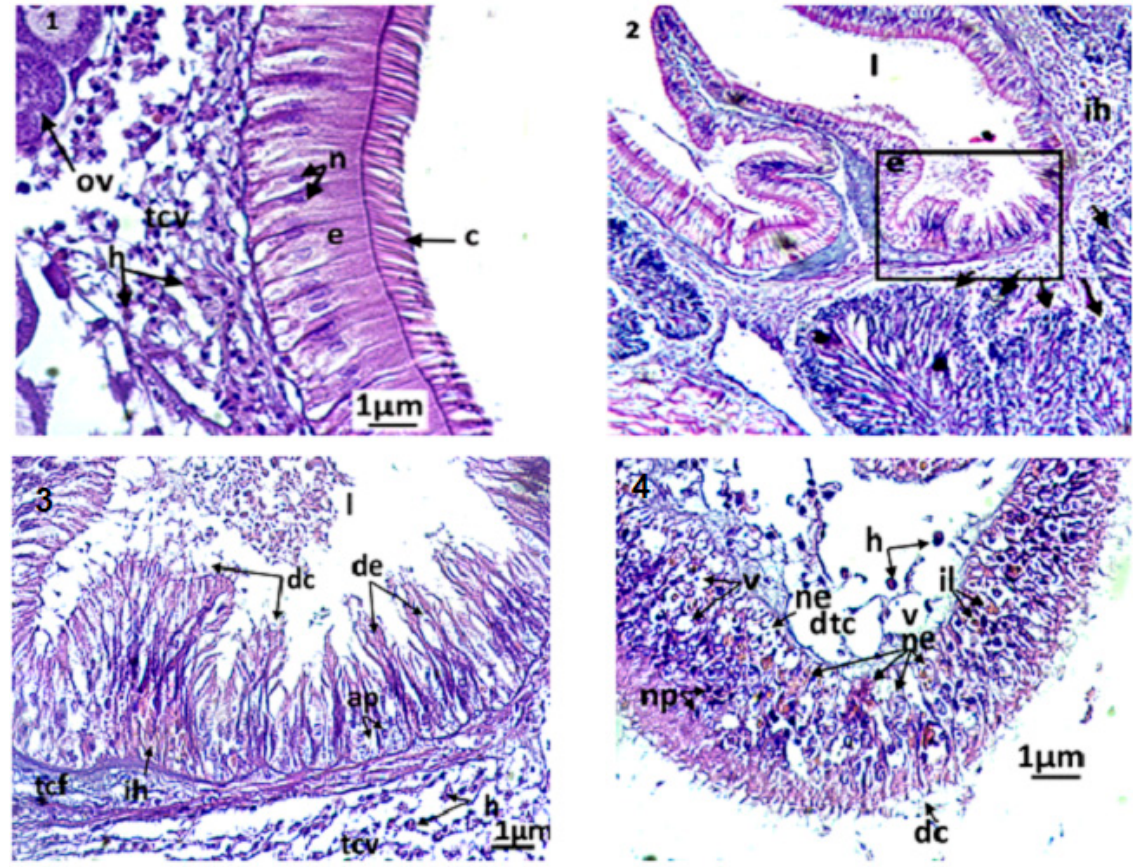
Figure 5. Micrographs at the digestive tract of Ruditapes decussatus exposed or not to triclosan. ( 1 ): Microphotography of the intestinal epithelium of control clams. C: eyelashes; e: pseudostratified epithelium; h: hemocytes; ov: oocyte; n: normal nucleus; tcv: vesiculated connective tissue. ( 2 , 3 ): microphotography showing the stomach and male acini of a treated individual (C3, 3 days). The arrows indicate the degeneration of the acini (desquamation of the basal membrane). ap: apoptotic nuclei; ih: hemocytic infiltration; l: stomach light; tcf: fibrous connective tissue; de: degenerated ep- ithelium; dc: cellular debris. ( 4 ): dtc: degeneration of the connective tissue; h: hemocyte; il: inclusion of lipid granules; ne: necrosis of the epithelium; np: pyknotic nucleus; v: vacuolization.